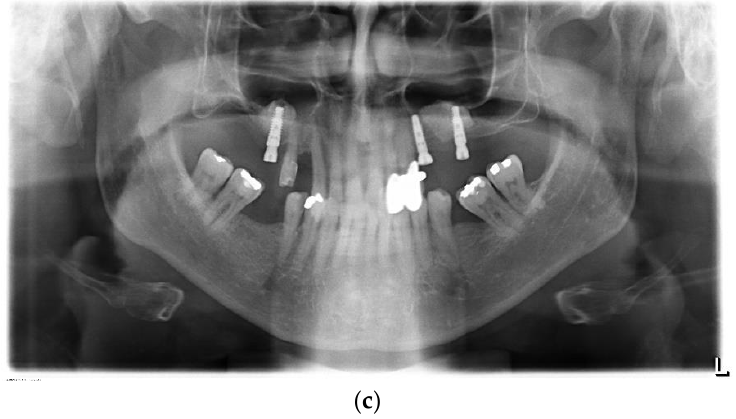
Figure 5. Radiographical outcome ( a ) Sagittal plane of the left maxillary sinus directly after augmentation. An air-fluid-level of blood is visible after a small perforation of the Schneiderian membrane. The scaffold is tightly fixed to the host bone by the screw. ( b ) Sagittal plane of the left maxillary sinus prior to implant placement. The scaffold is showing sufficient osseointegration. The bone lid is visible cranial of the scaffold. No sign of inflammation or mucosal swelling is detectable in the sinus. ( c ) Panoramic radiograph after implant uncovering. A sufficient osseointegration of the scaffolds and the dental implants without any signs of peri-implant osteolysis is obvious. No sign of inflammation of the maxillary sinuses is detectable.